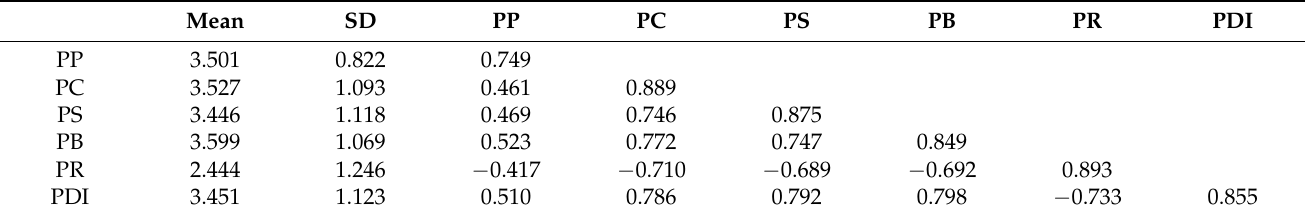
Table 3. Discriminatory validity of